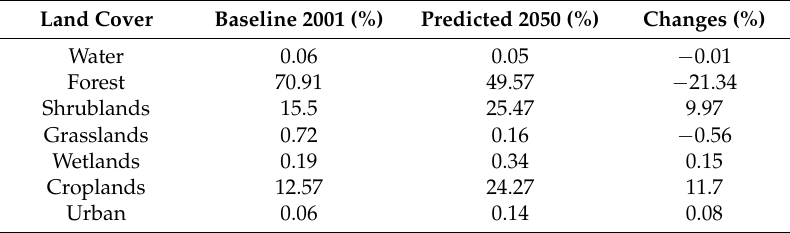
Table 3. Potential land cover change simulated by LCM in the Da River Basin (area percent: %). Land Cover Baseline 2001 (%)